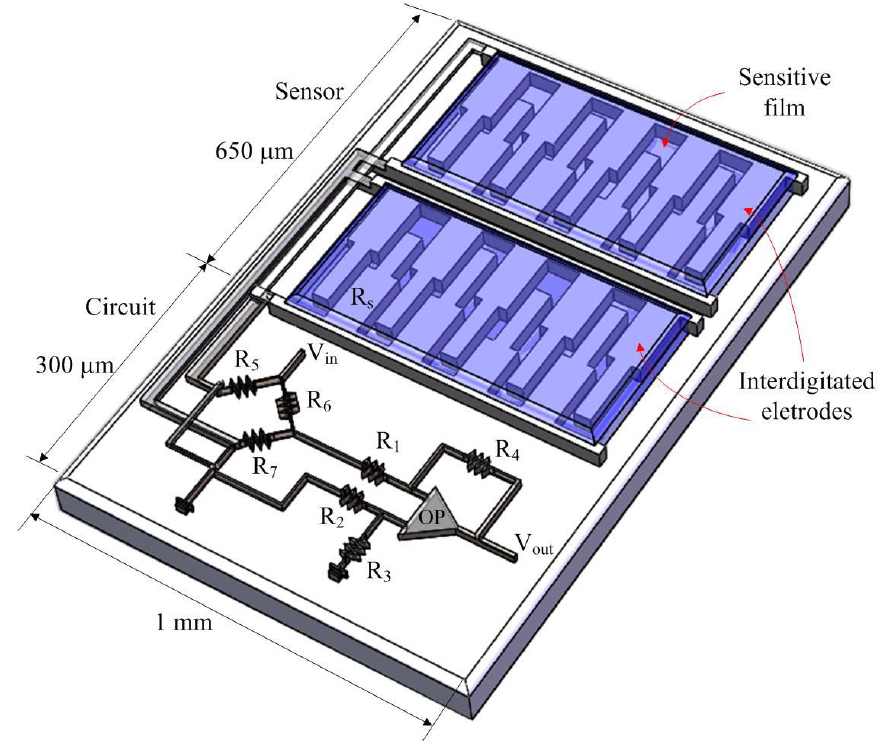
Figure 1. Schematic structure of the integrated humidity